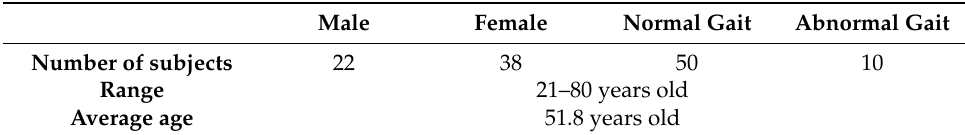
Table 3. Summary of study